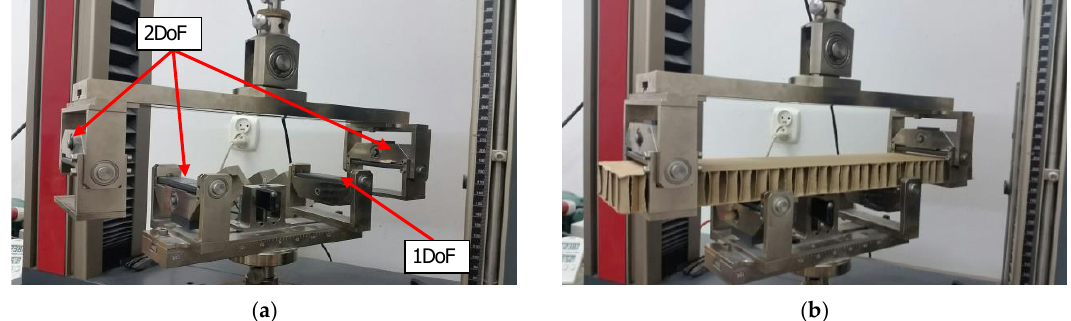
Figure 5. Tool for measuring bending stiffness ( a ) and a sample of the honeycomb paperboard placed in the tool ( b ).